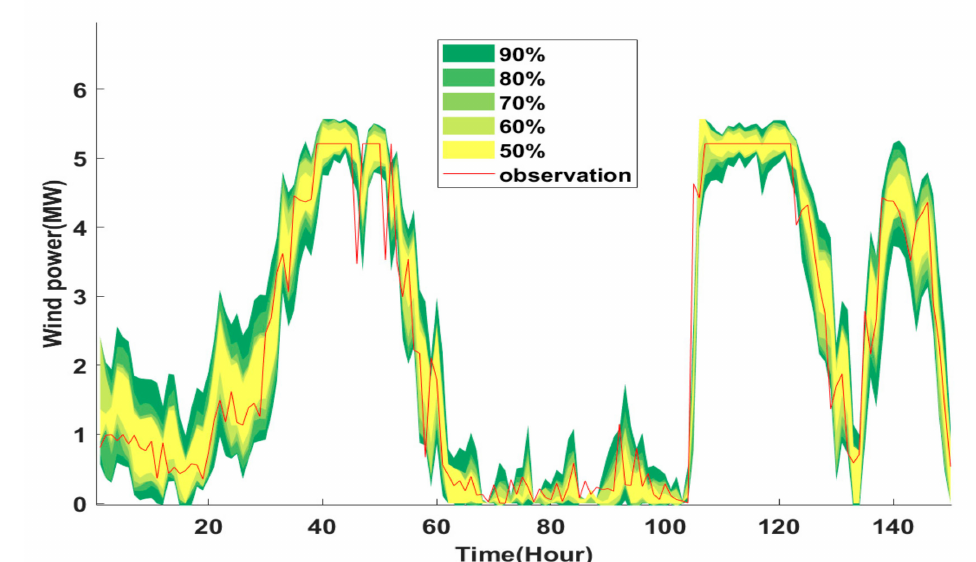
Figure 12. Three-h-ahead probabilistic forecasting results by proposed method. WRFD, deterministic WRF; RWRF, radar WRF;